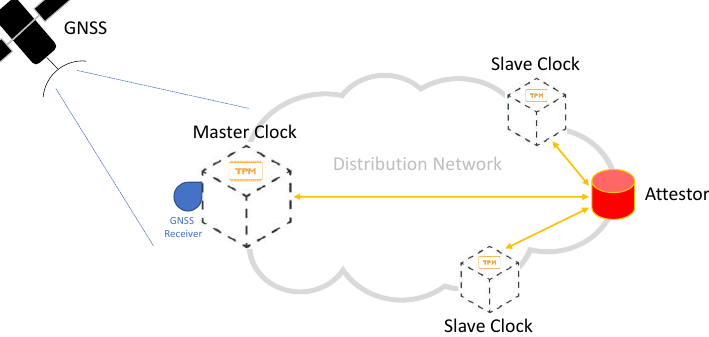
Figure 4. Illustration of Remote Attestation on the synchronization distribution